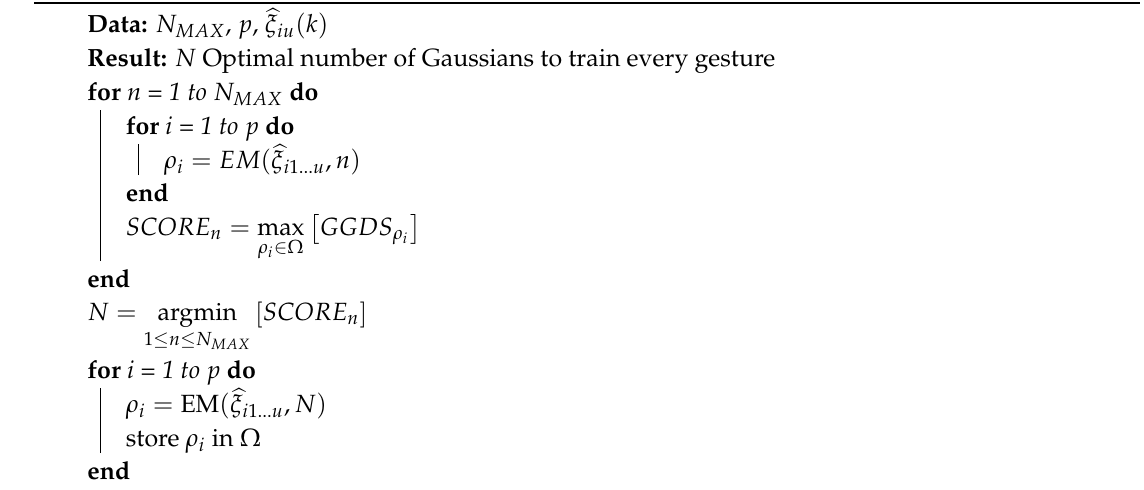
Algorithm 1: Algorithm that obtains the best number of Gaussians N for the training sequences of several gestures using the GGDS